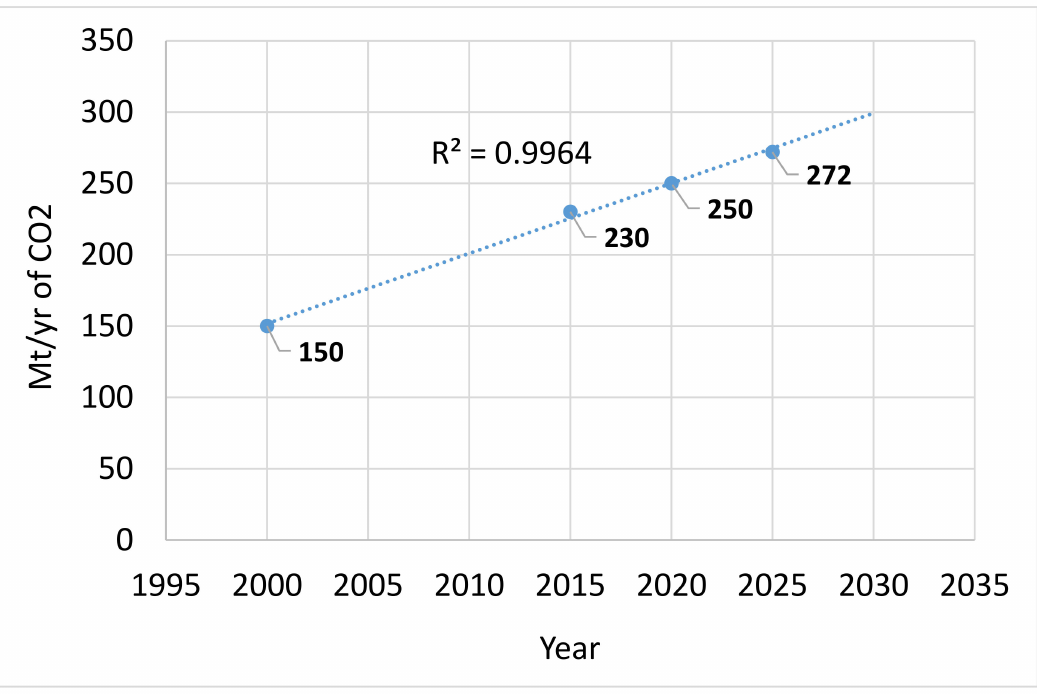
Figure 7. Growth in global CO 2 demand, source of data: IEA [44].